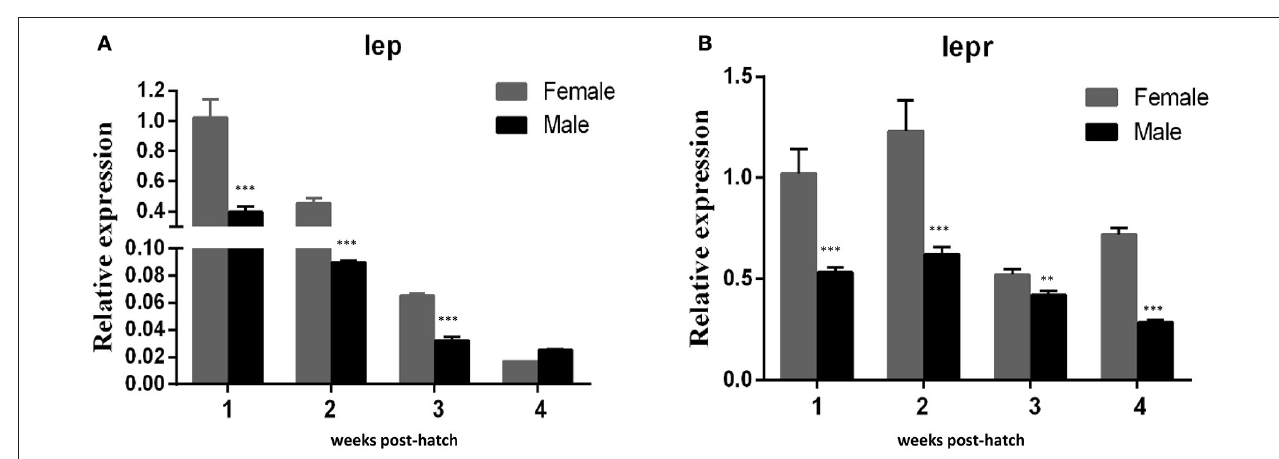
FIGURE 1 | Expression of lep and lepr in juvenile fish among 1–4 weeks post hatching. (A,B) Indicated the relative expression levels of lep and lepr gene during juvenile fish, respectively (** P < 0.01 and *** P < 0.001).